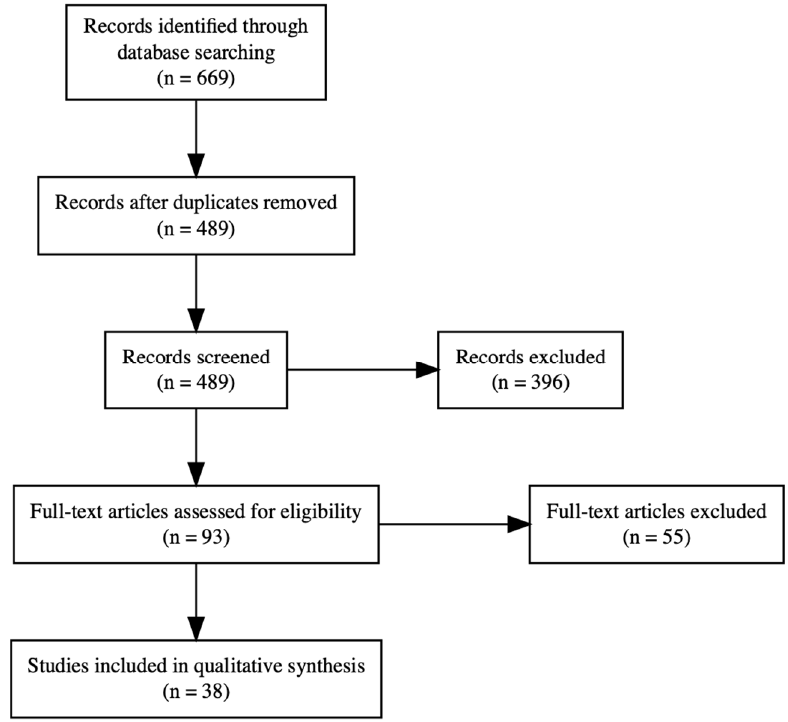
Figure 1. PRISMA flow chart.